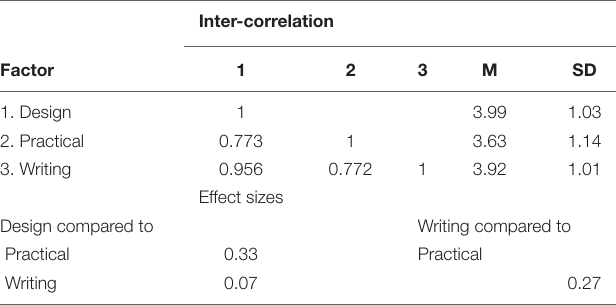
TABLE 8 | Inter-correlation of the three-factor research